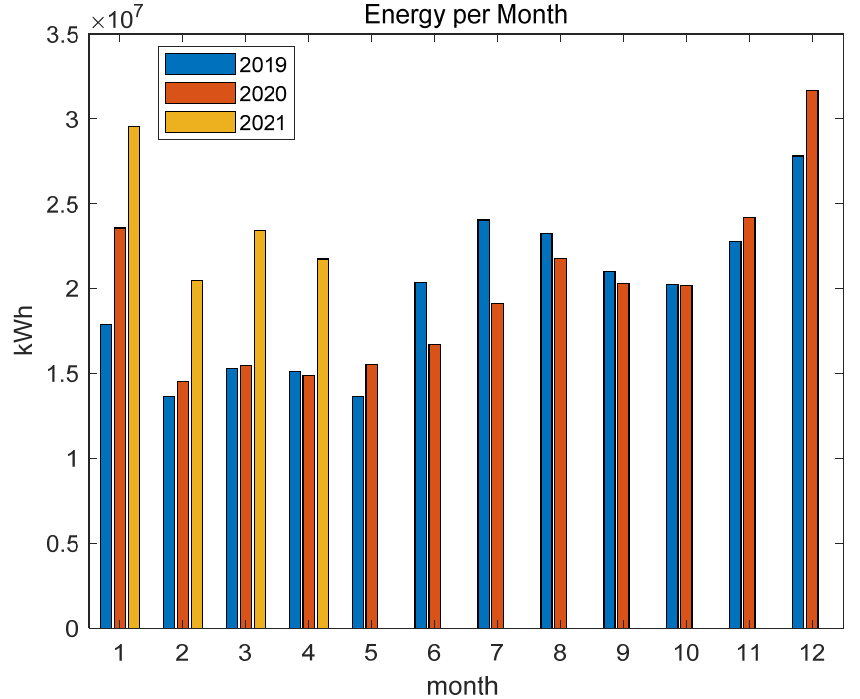
Figure 2. Monthly electricity consumption data of charging stations from 2019 to 2021 .